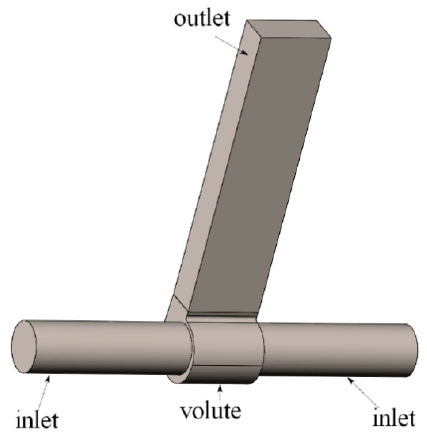
Figure 3. Geometrical model of the centrifugal fan.